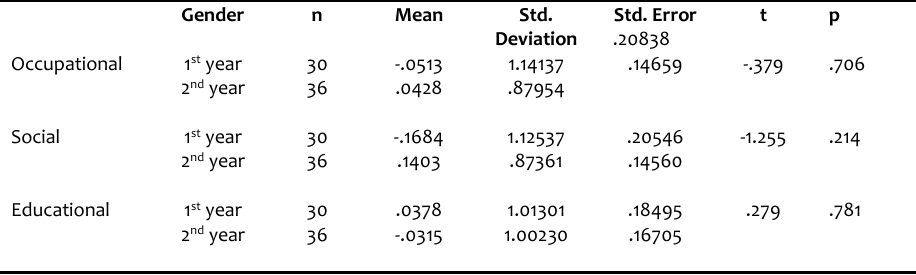
Table 4. T-Test to Determine If the Learning Needs of the Student Participants Differed According to Their